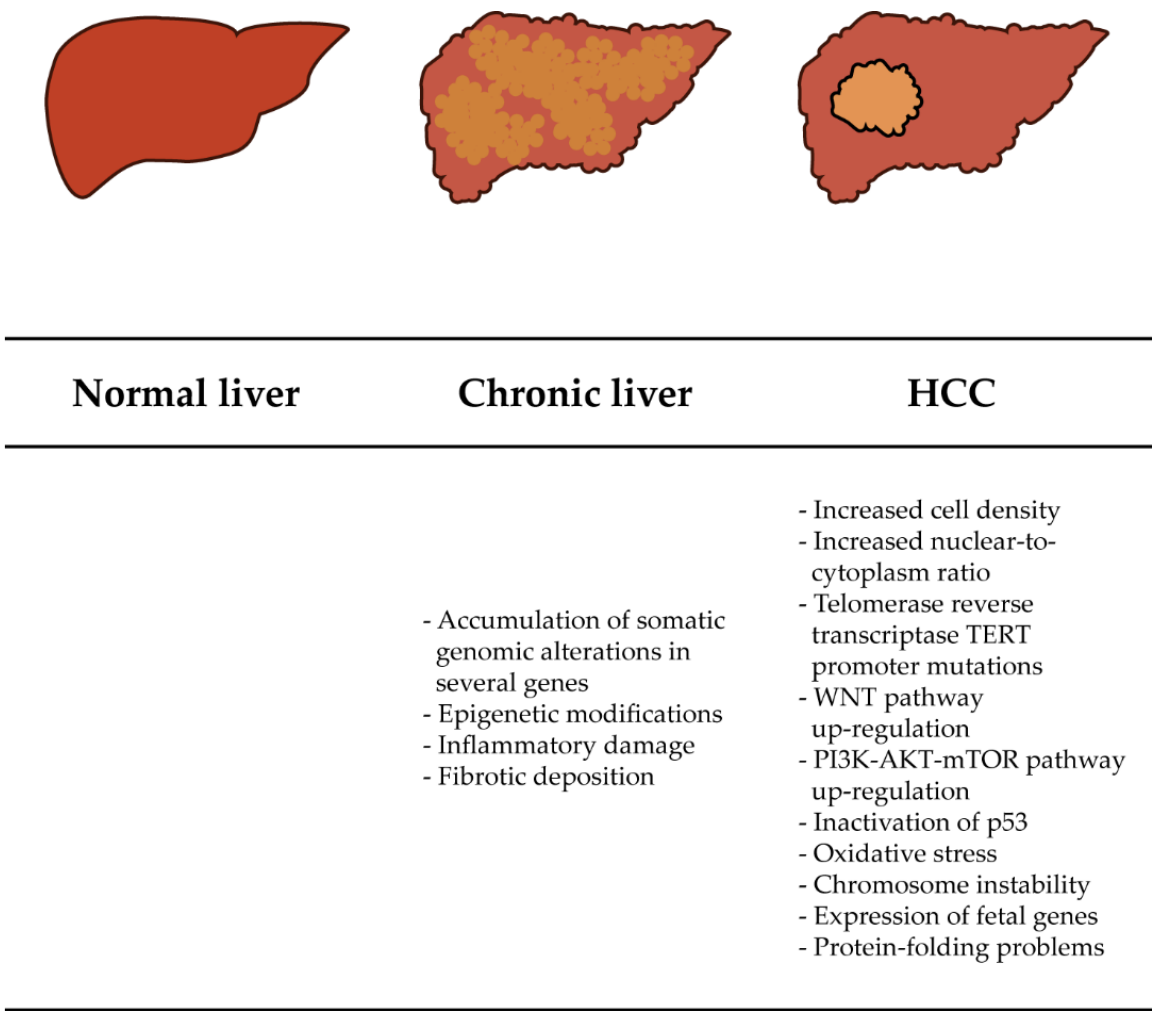
Figure 1. HCC pathogenesis. Chronic liver diseases involve changes leading from a normal and healthy liver to a state of cirrhosis presenting inflammatory damage and fibrotic tissue. The continuous inflammation caused by cirrhosis produces somatic genomic alterations and epigenetic mutations, which progress to HCC. HCC cells present an increased nuclear-to-cytoplasm ratio. Furthermore, HCC is characterized by several alterations in the proliferation pathways, protein expression and folding, and oxidative stress.